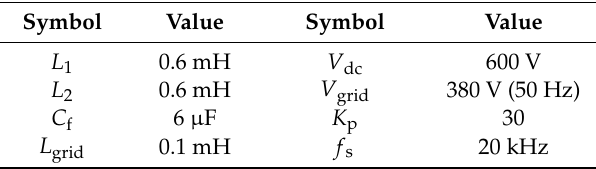
Table 1. Parameters of the